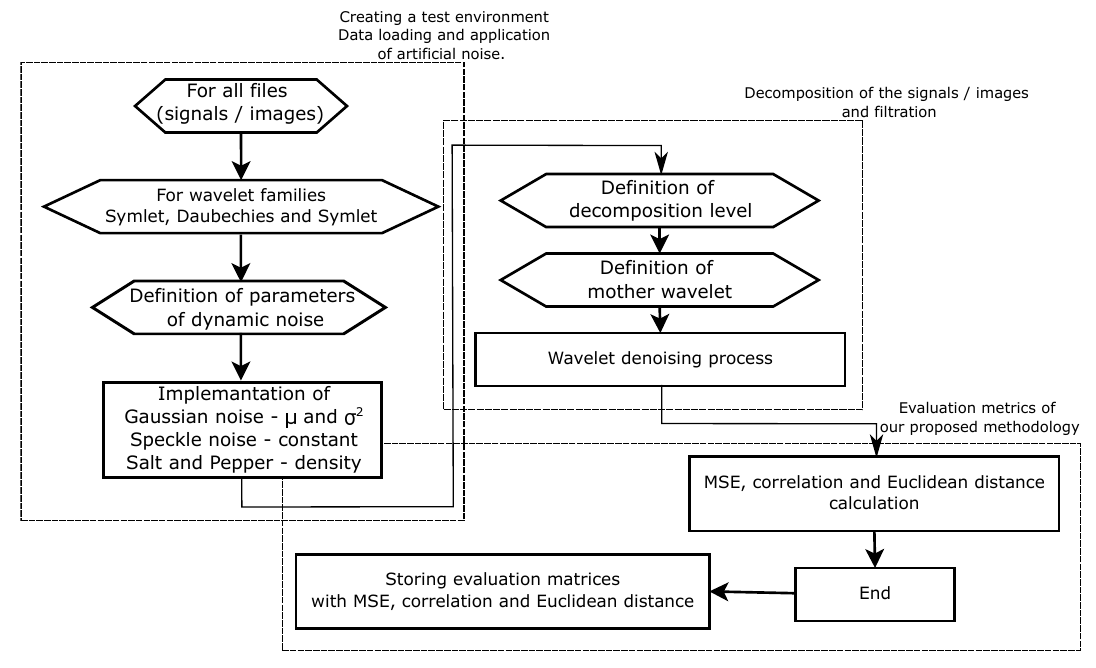
Figure 3. A scheme of a proposed algorithm for 1D and 2D signal (e.g., EMG, CT or MRI)